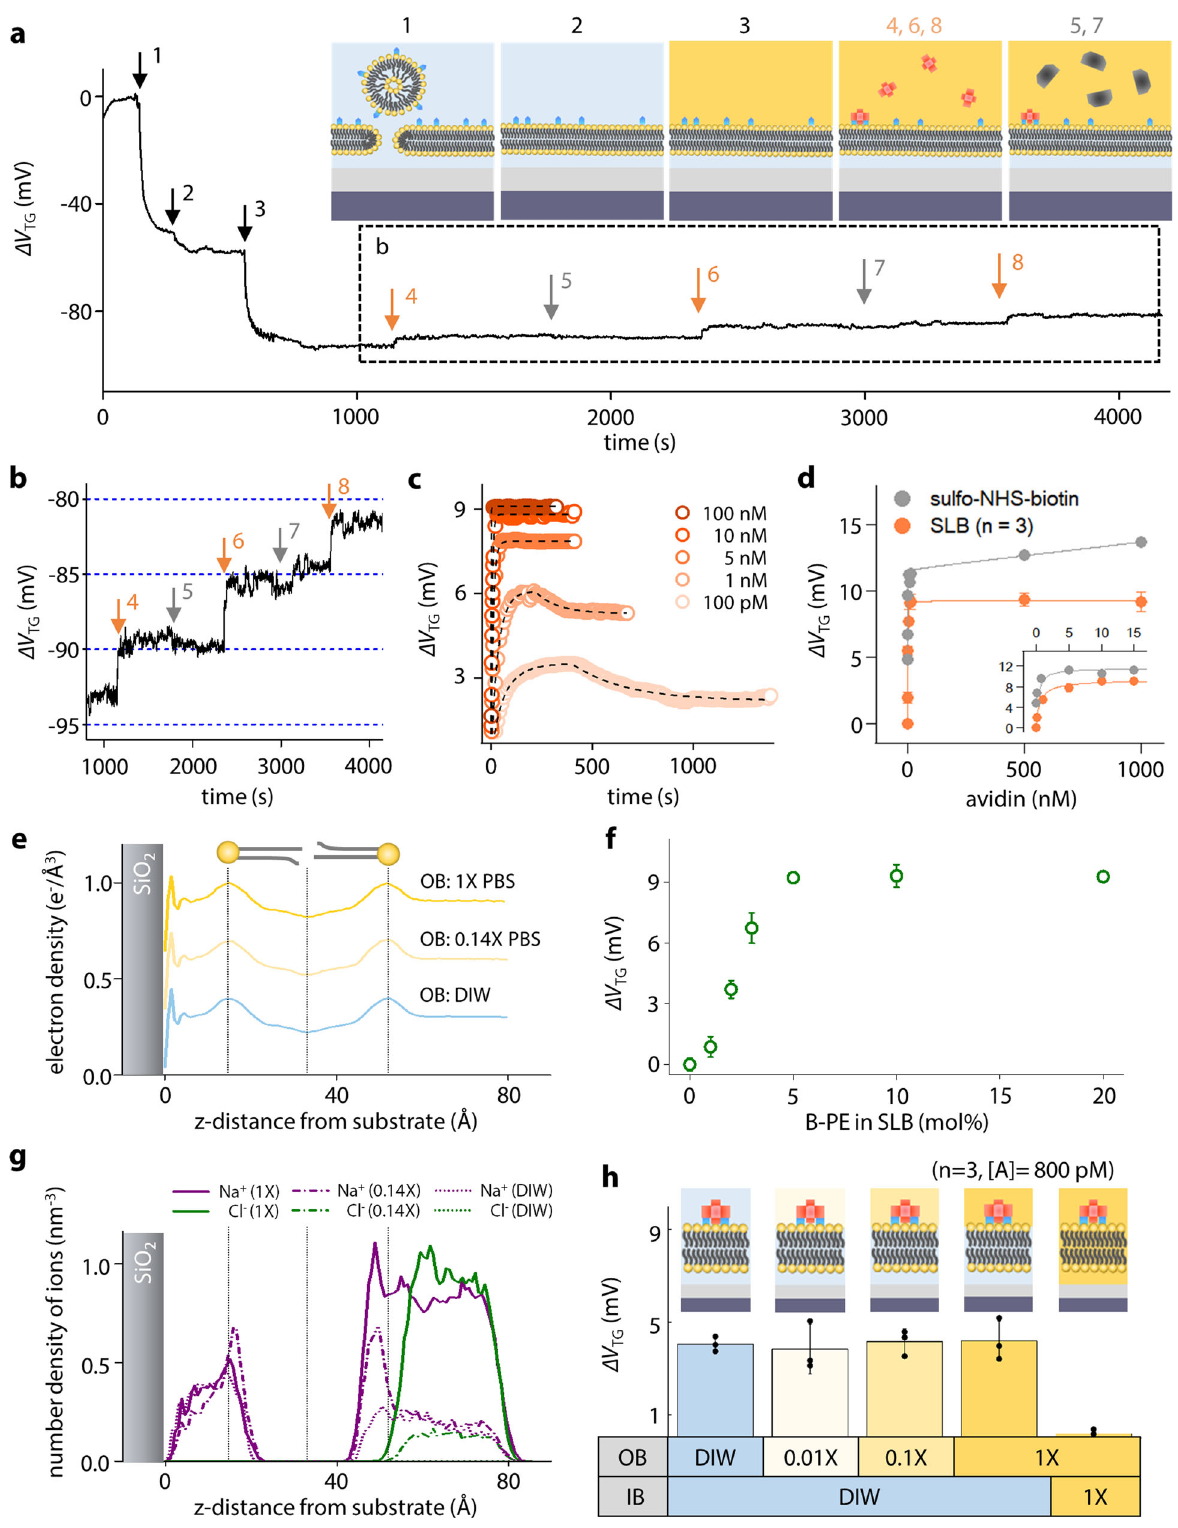
obtained responses, an analytical model was suggested by combining the Langmuir isotherm model with the information of capacitively induced charges on the gate electrode of the